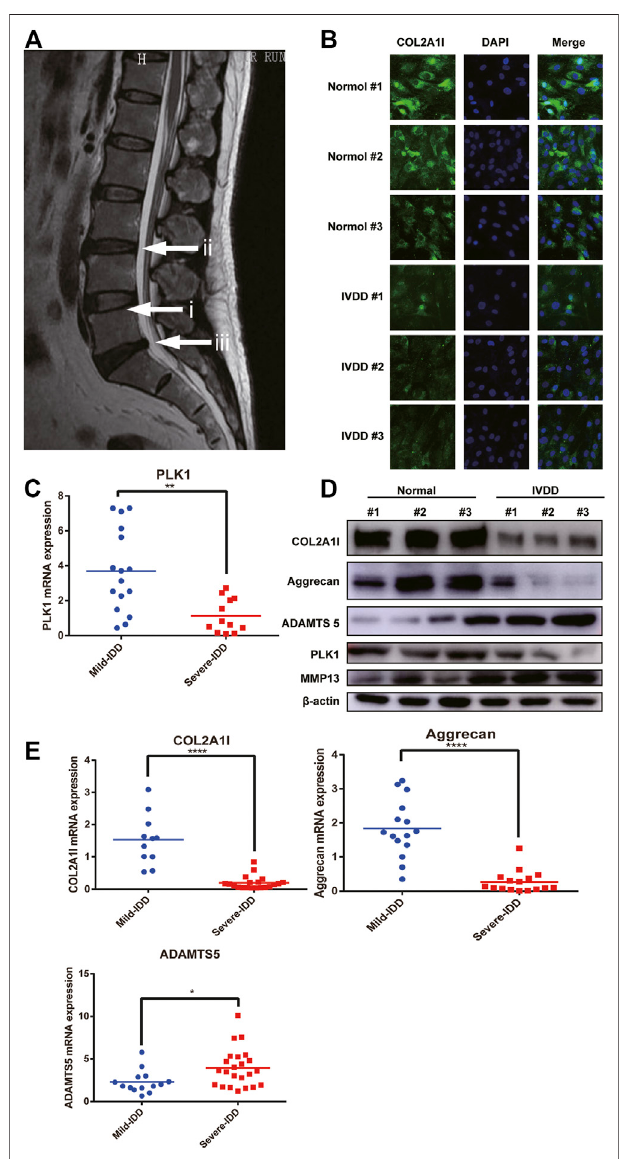
FIGURE 1 | PLK1 expression is decreased in NPCs in IVDD. (A) Preoperative MRI scan of the spine of IVDD. (i) refers to normal intervertebral disc tissue, and (ii, iii) refers to degenerated intervertebral disc tissue. (B) The expression of collagen in NPCs from normal and degenerate IVDs. (C) The mRNA expression of PLK1 in NPCs isolated from different degenerated IVDs. (D) The protein expression of collagen, aggrecan, ADAMTS5, PLK1, and MMP13 in NPCs isolated from different degenerated IVDs. (E) QPCR analyses were performed for collagen, aggrecan, and ADAMTS5. Data are shown as the mean ± SD, * p < 0.05, ** p < 0.01, ** p < 0.001, **** p < 0.0001. SD, standard deviation.